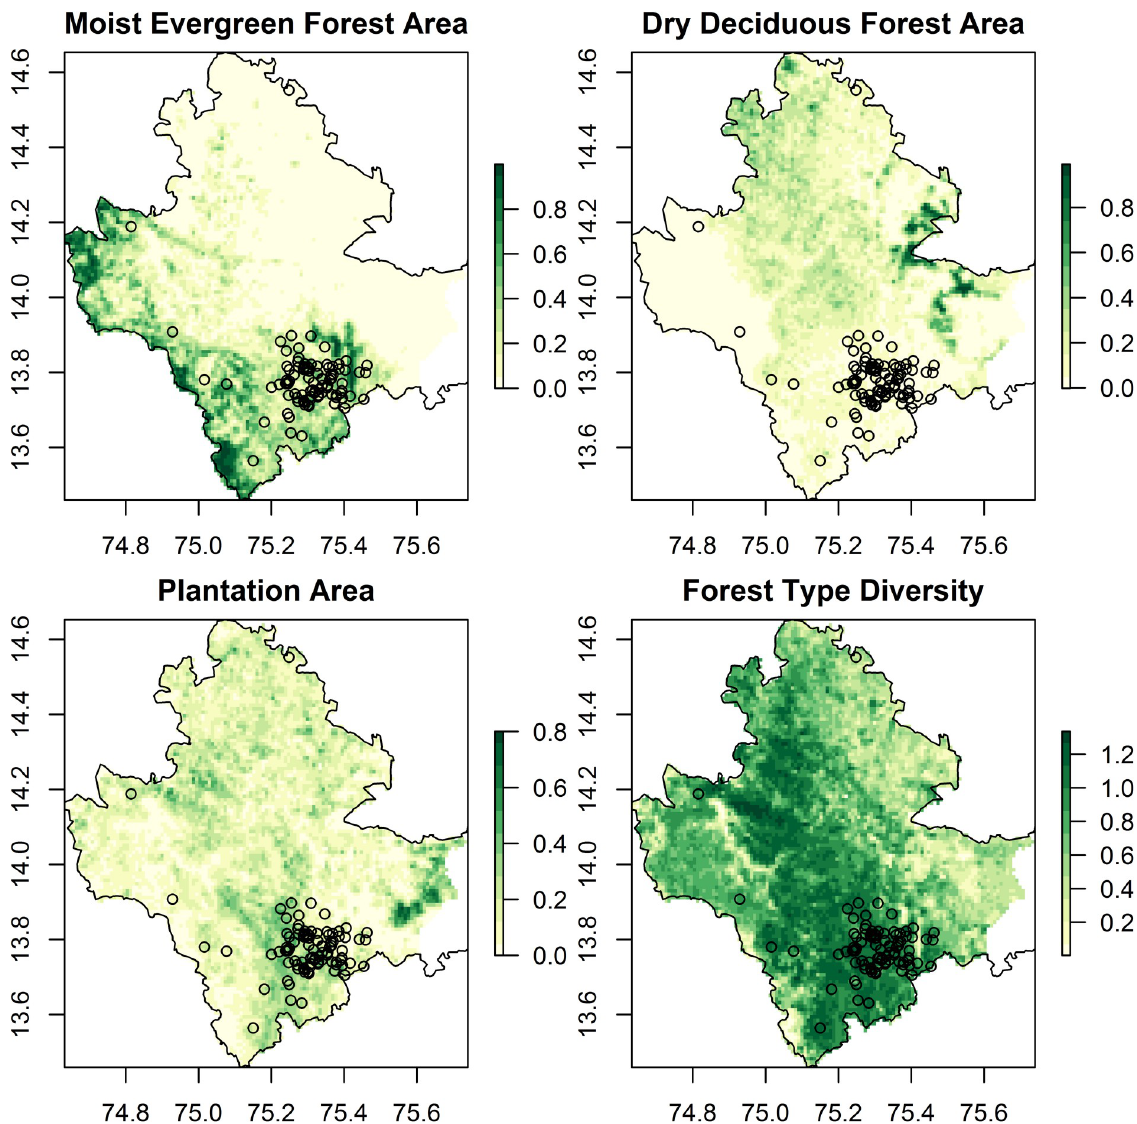
Fig 2. Key landscape predictors of presence of Kyasanur Forest Disease (1 km resolution) overlaid with point locations of human cases from 2014 to 2018 (black dots).). These are proportional areas of moist evergreen forest, dry deciduous forest, and plantation per grid cell and forest type diversity. These metrics were derived from analysis of the MonkeyFeverRisk LULC map (see S3 and S4 Files). The administrative boundary dataset is from HindudstanTimesLabs (https://github.com/HindustanTimesLabs/shapefiles/), reproduced under the MIT License. Human case data are from the Department of Health and Family Welfare Services, Government of Karnataka. White areas in Bhadravathi taluka in southeast corner indicate no data.